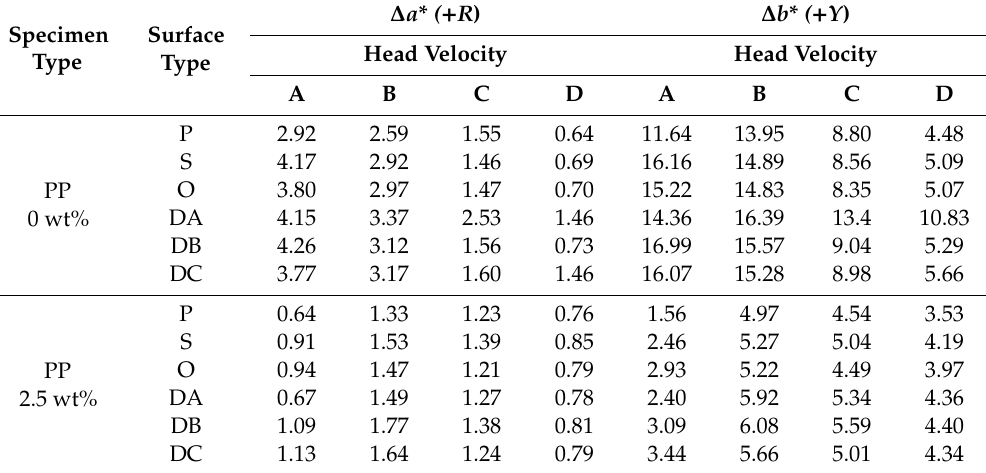
Table 5. Color changes in the marked areas in relation to the remaining surface in axes a and b, depending on the content of the Lifolas M Schwarz 113504 UN filler, a type of surface of the forming insert and the velocity of a laser